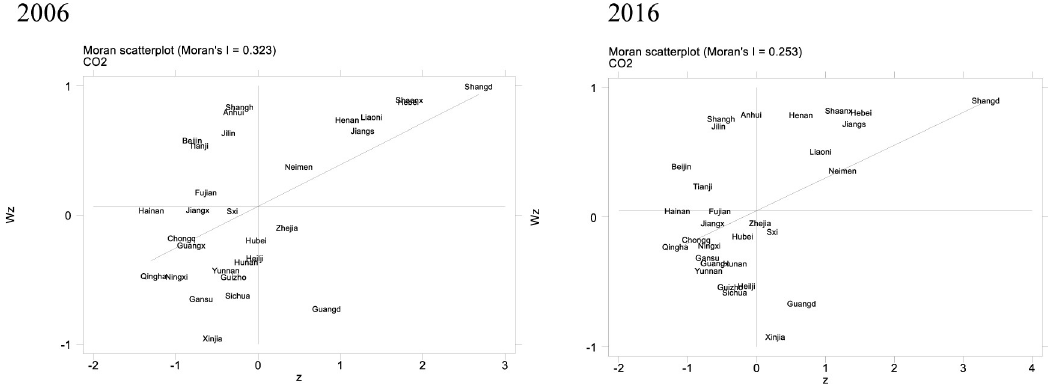
Fig 5. Moran’s I scatter diagram of CO 2 emissions in provinces of